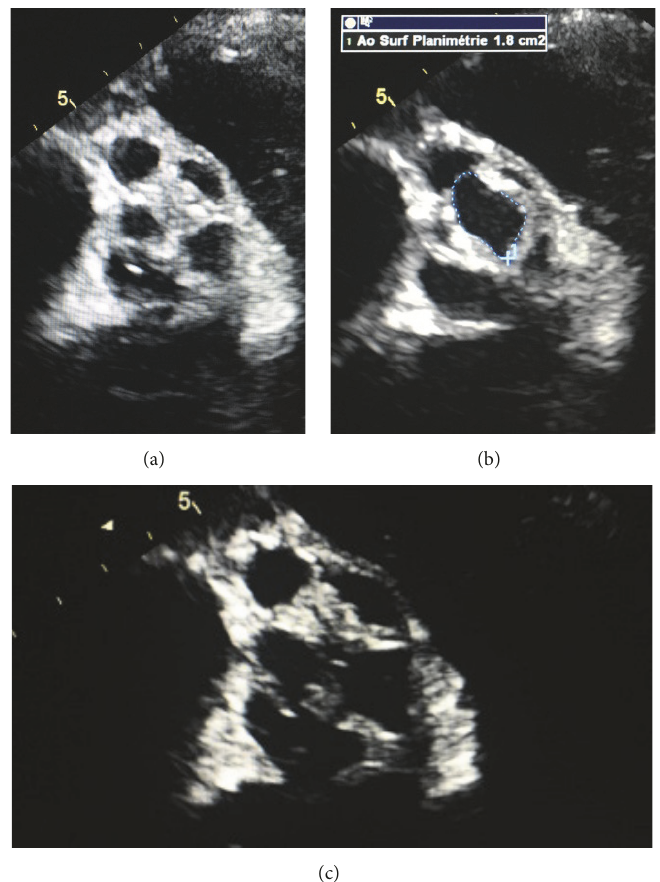
Figure 1: TTE: parasternal short axis view showing type A quadricuspid aortic valve in systole (a) and diastole with a planimetric aortic valve area of 1.8cm 2 (b). (c) shows type A quadricuspid aortic valve during systole along with two fistulae, the first between the left sinus of Valsalva and the left atrium (LA) and the second between an aortic periannular abscess and LA.